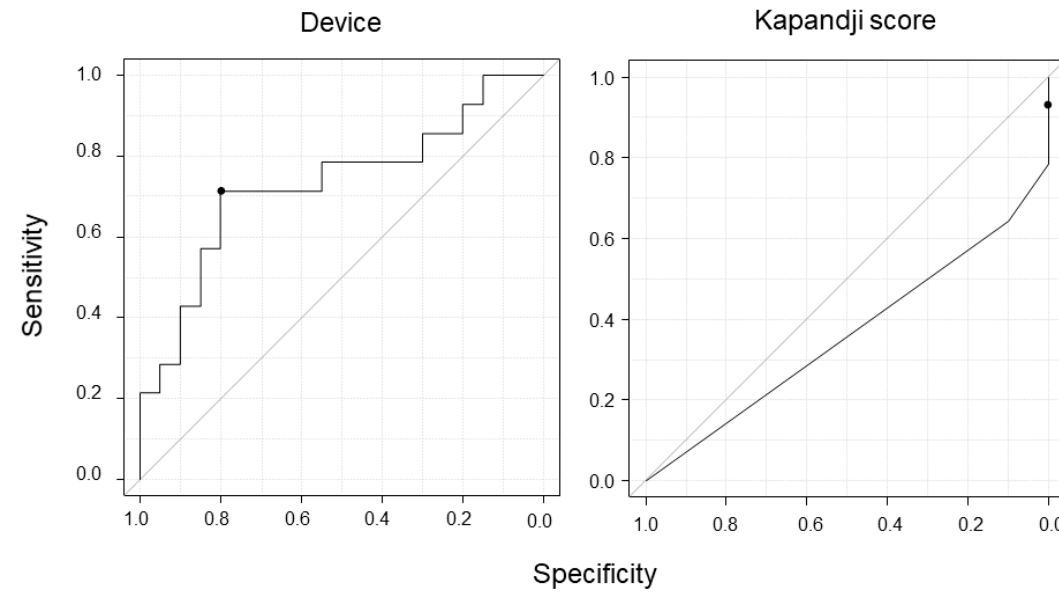
Figure 7. Receiver operating characteristic curves of our device method and the Kapandji score. The black dot indicates the cutoff point.